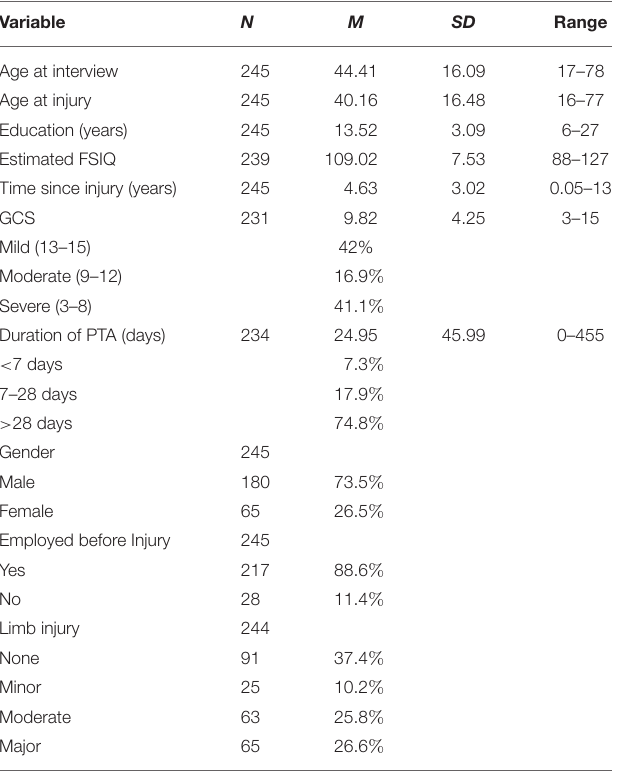
TABLE 1 | Demographic, injury, personal, and environmental characteristics of participants with traumatic brain injury ( n =